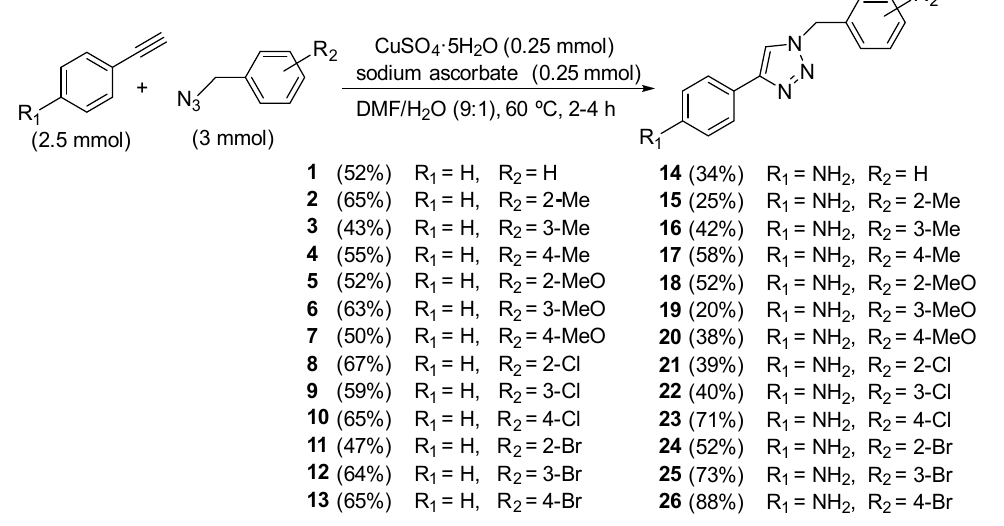
Scheme 1. Synthesis of triazole derivatives.